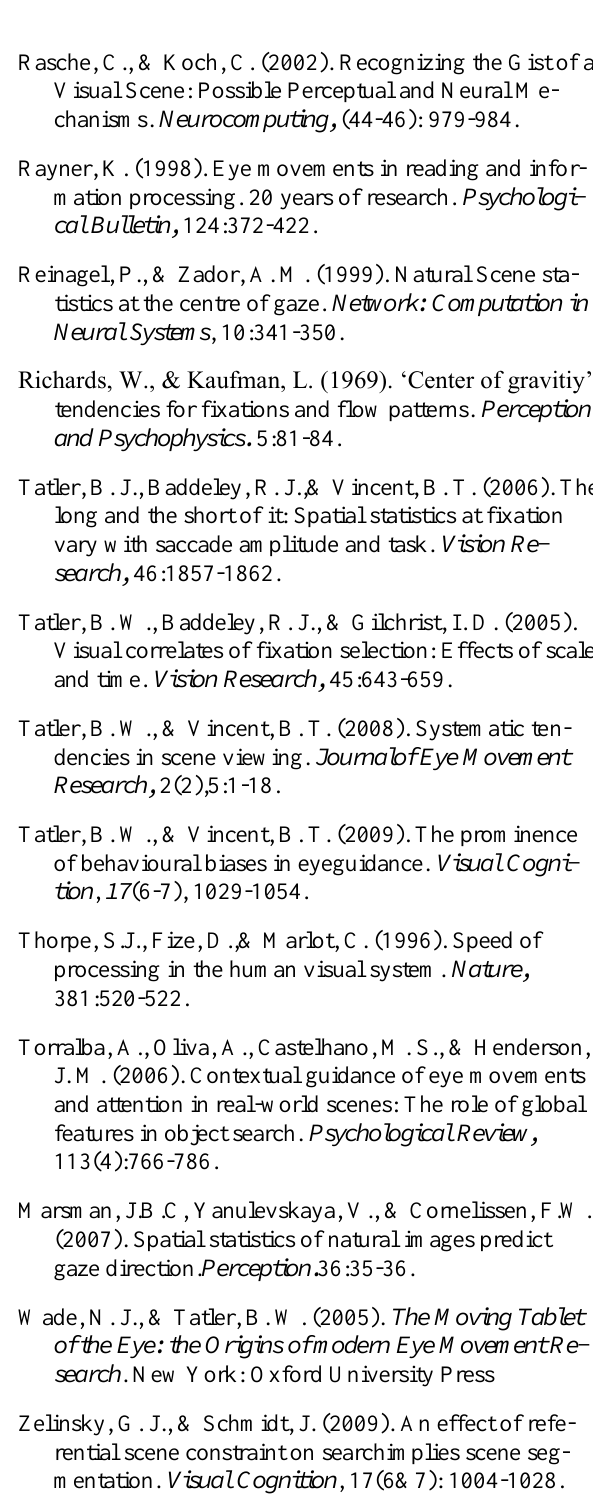
Evidence for a Structural Analysis of Target Selection in Picture